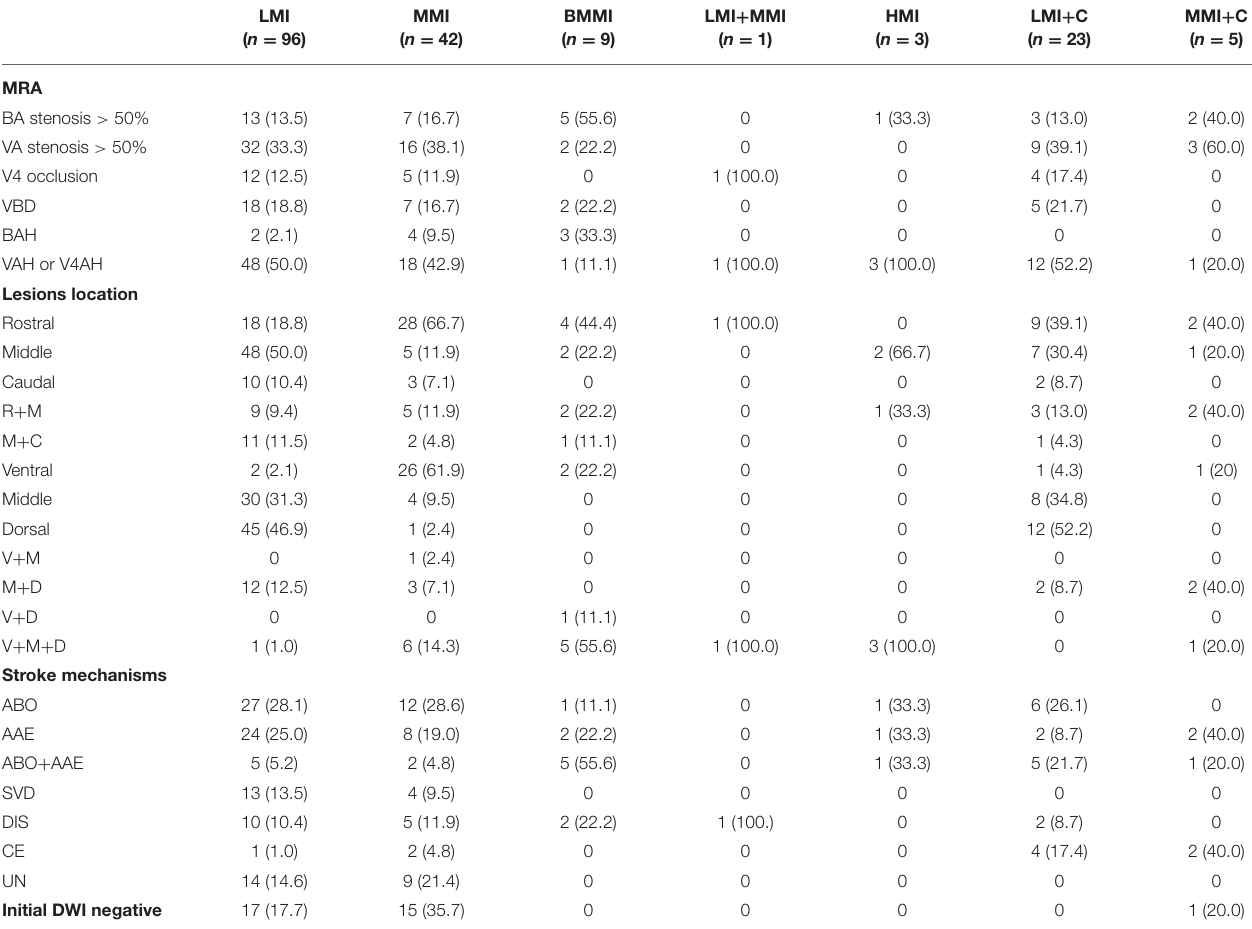
TABLE 2 | Imaging characteristics of 179 patients with medullary